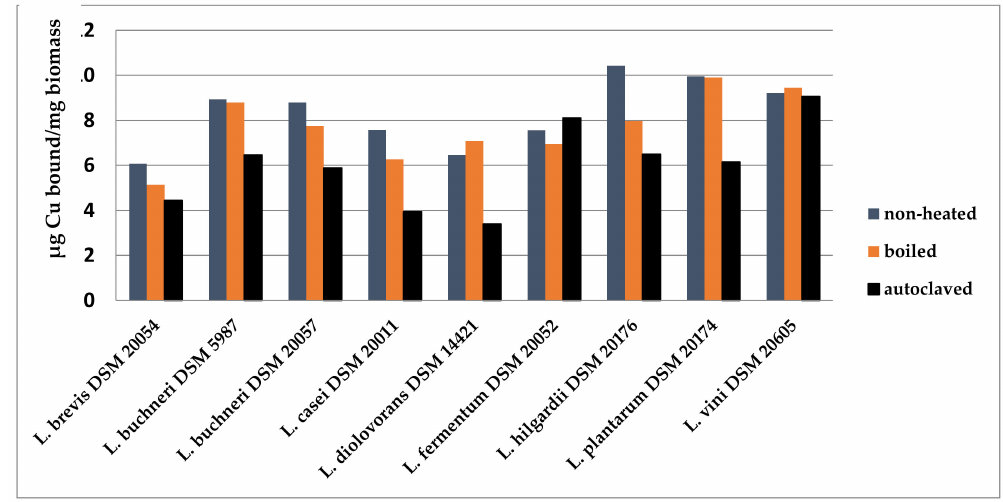
Figure 1. E ff ect of heat treatment on the copper binding capacity of wine-relevant Lactobacillus species. Conditions: Deionized water at pH 5.0 with 40 µ g Cu 2 + / mL, biomass concentration 1 mg / mL, and incubation time 1 h [15,24].